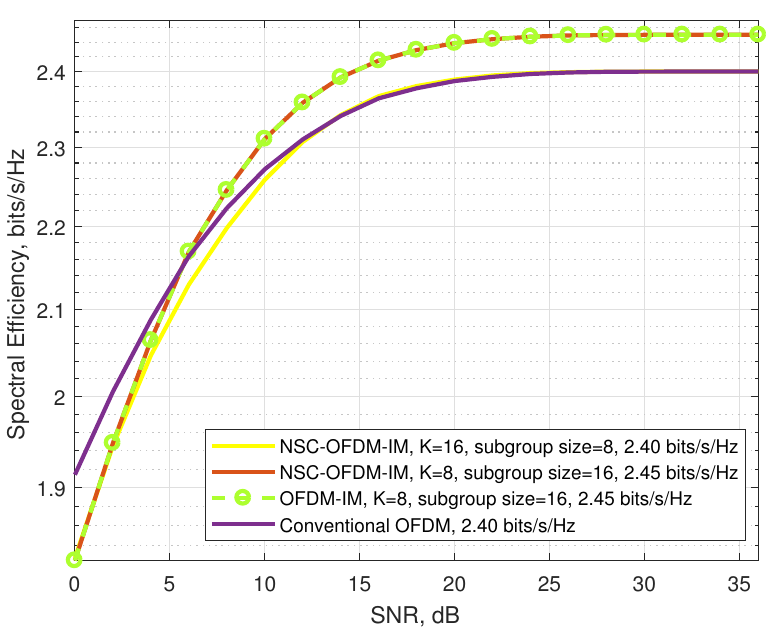
Figure 14. Comparison of the proposed NSC-OFDM-IM with conventional OFDM/OFDM-IM in terms of spectral efficiency, where 8-PSK modulation was